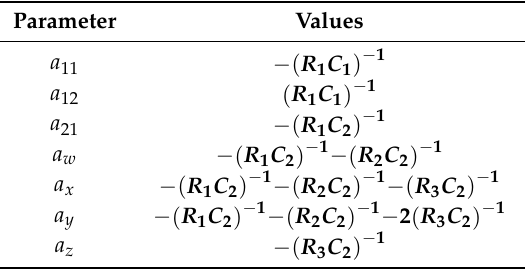
Table 2. Parameters of the state–space model.